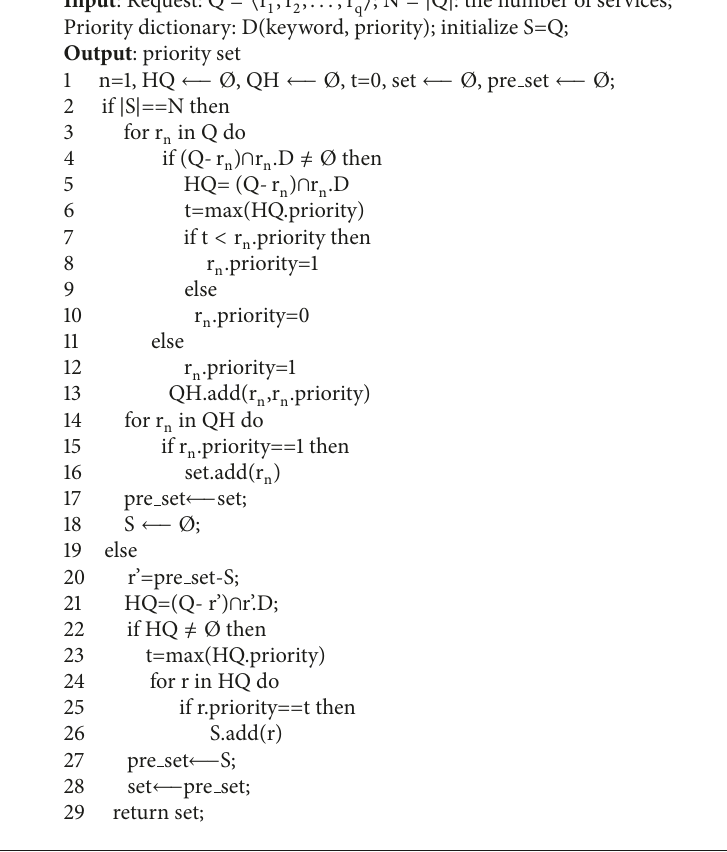
Algorithm 3 assigns priority for query keywords and